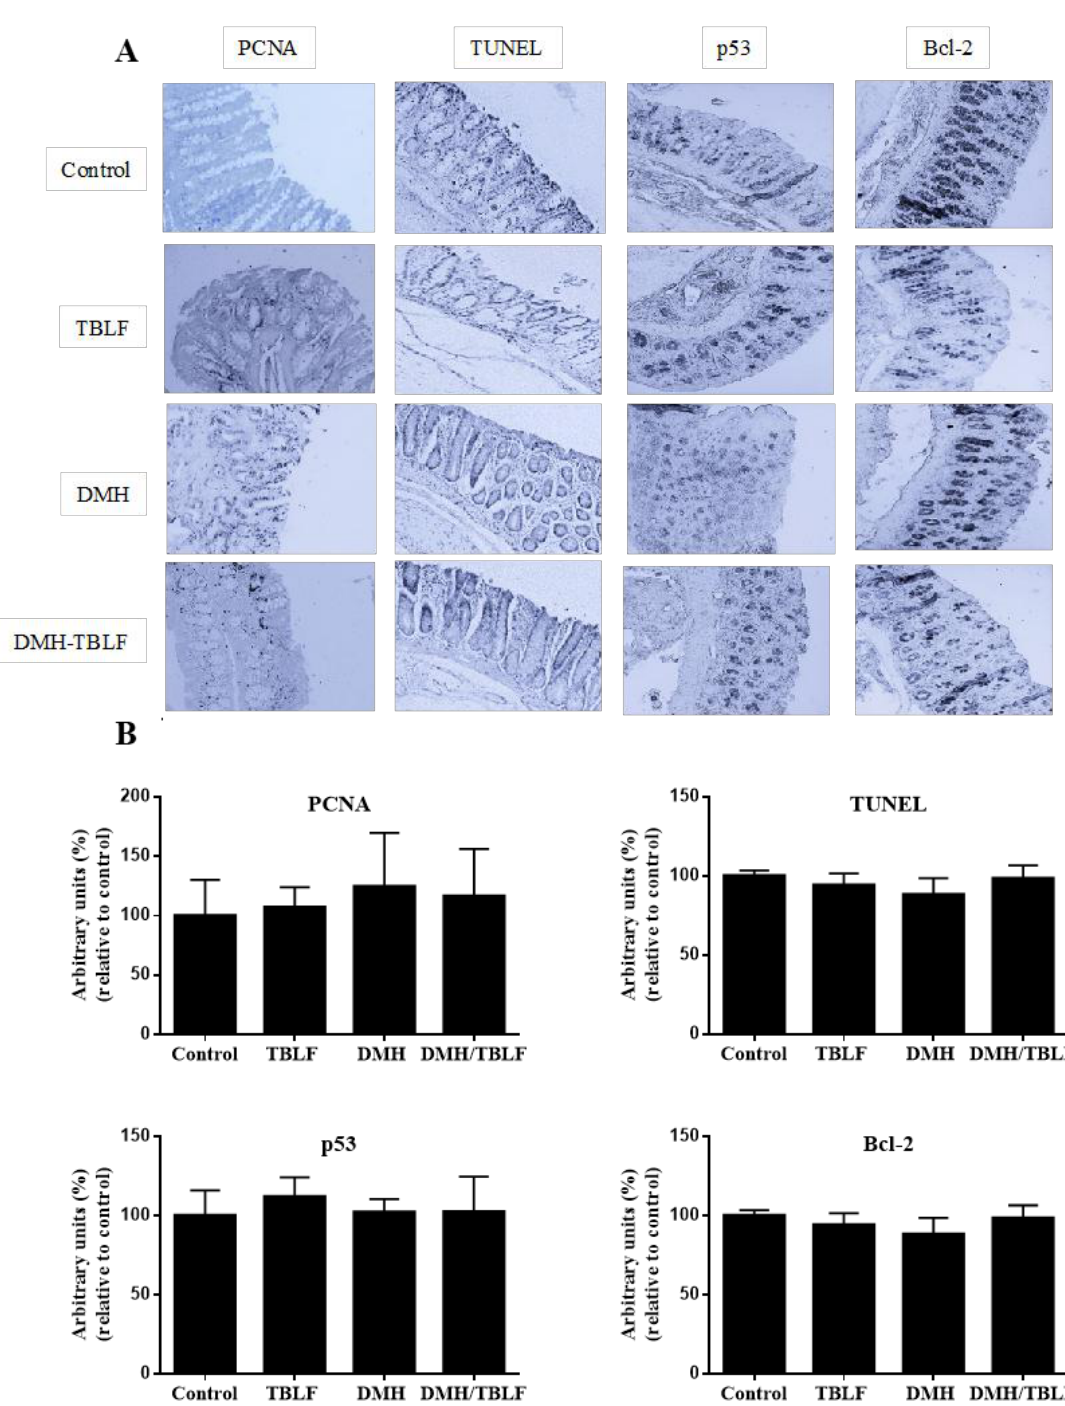
Figure 4. Immunohistochemical analyses of proliferation and apoptosis markers in colon lesions provoked by DMH and treated with TBLF. Rats were administered DMH for eight weeks for the development of cancer lesions followed by intra-gastric administration of TBLF (50 mg/kg) on alternate days for six weeks. ( A ) Representative micrographs of each group (10 × ); ( B ) Densitometry analyses of immuno-stained colon tissues. No significant difference by one-way ANOVA (Dunnett, p < 0.05) was found. No significant changes were observed between treatments.